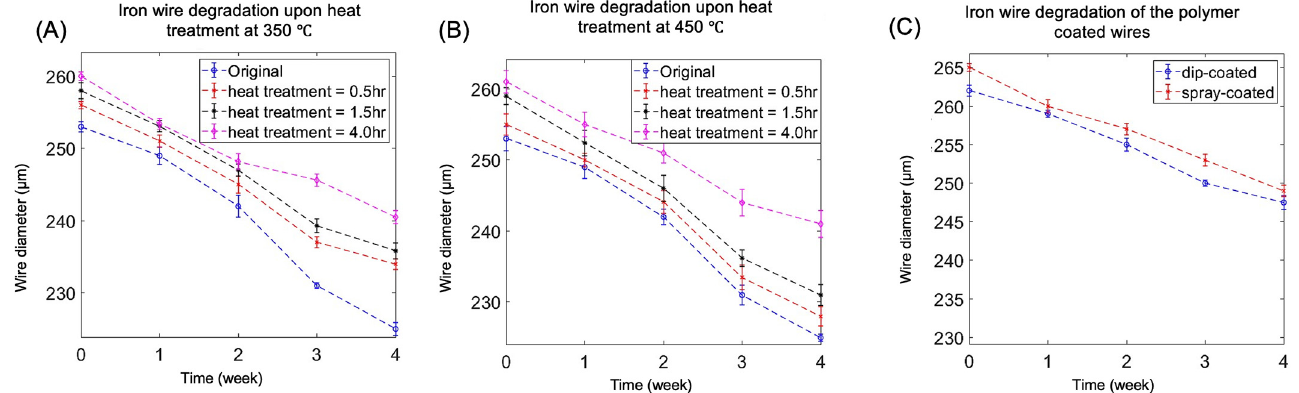
Figure 5. Iron wire diameter ( µ m) vs. the testing time (week): ( A ) heat-treated at 350 ◦ C, ( B ) heat-treated at 450 ◦ C, and ( C ) polymer-coated wire.